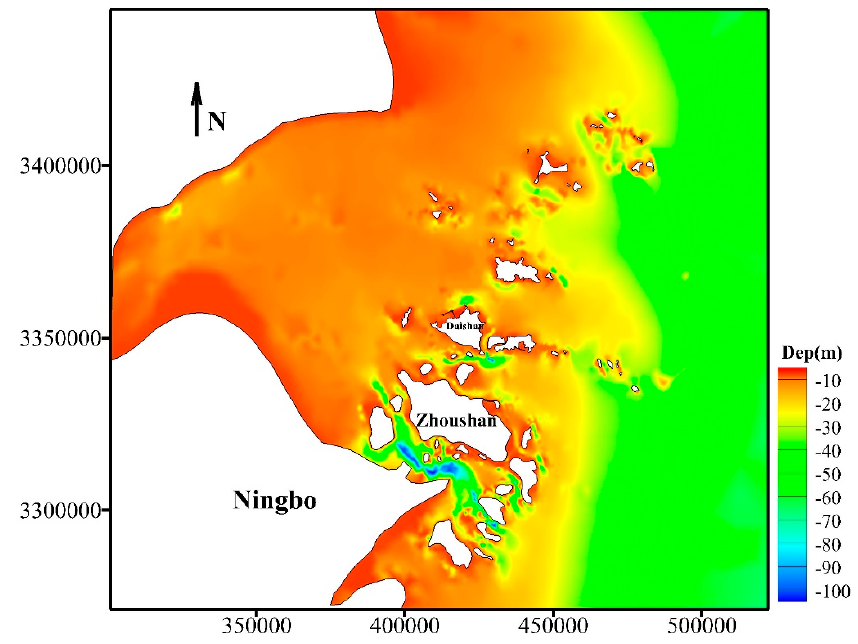
Figure 3. The study area of relief map.